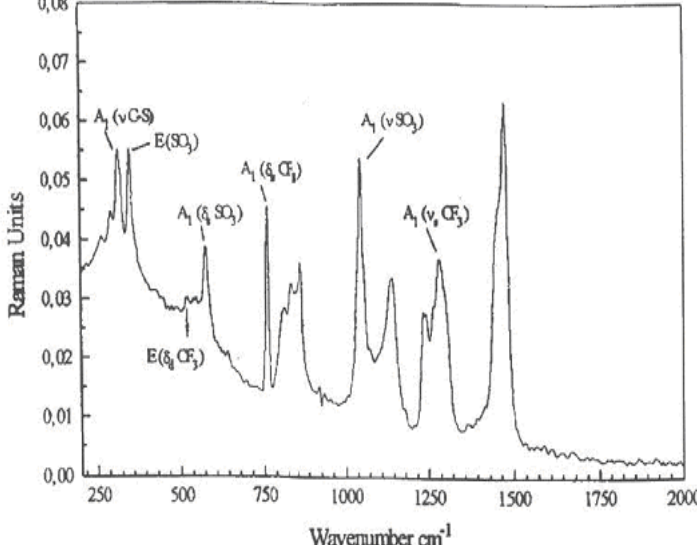
Figure 2. Raman spectra of LiCF SO + (EG) DME (EO/Li = 10) at room temperature. 3 3 11 (EG) DME is dimethyl ethylene glycol with the chain length n = 11 and EO/Li = 10 is the 11 inverse molar ratio of LiCF SO to elements of ethylene oxide oligomer. Where ‘vs’, ‘s’ 3 3 and ‘m’ are spectral bands with ‘very strong’, ‘strong’ and ‘medium’ intensity, respectively. The assignments ‘sh’ indicates a band shoulder, ‘w’—a bandwidth, ‘ δ ’ and ‘ v ’—the deformations and valency vibrations in the corresponding molecular groups,